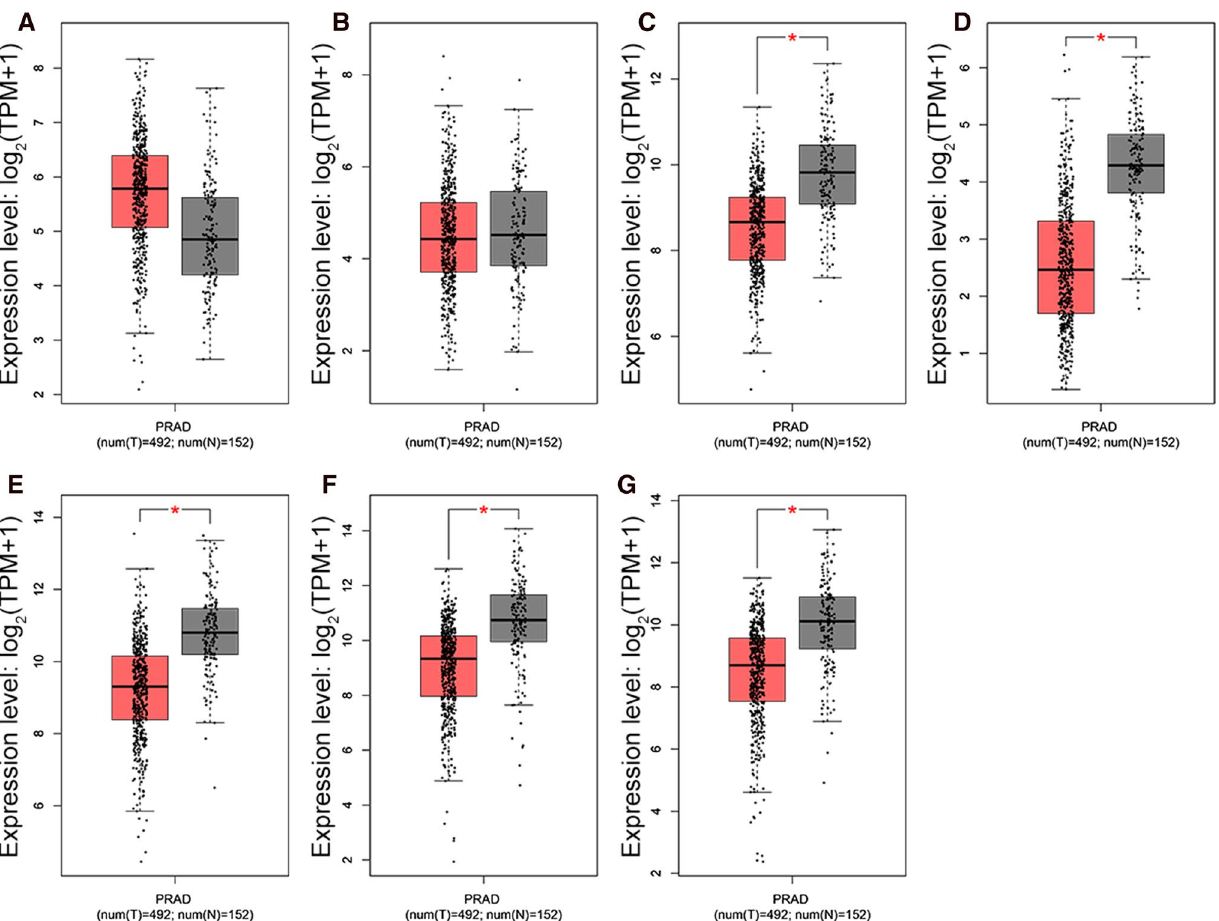
Fig. 3 The expression of hub genes between normal prostate and PCa samples from GEPIA depend on TCGA and GTEx data. A MYC , B CXCR4 , C CSRP1 , D SNAI2 , E MYL9 , F ACTG 2, G MYH11 . Red color represents tumor samples and gray color represents normal samples. * rep- resents statistical differences between two groups ( P <